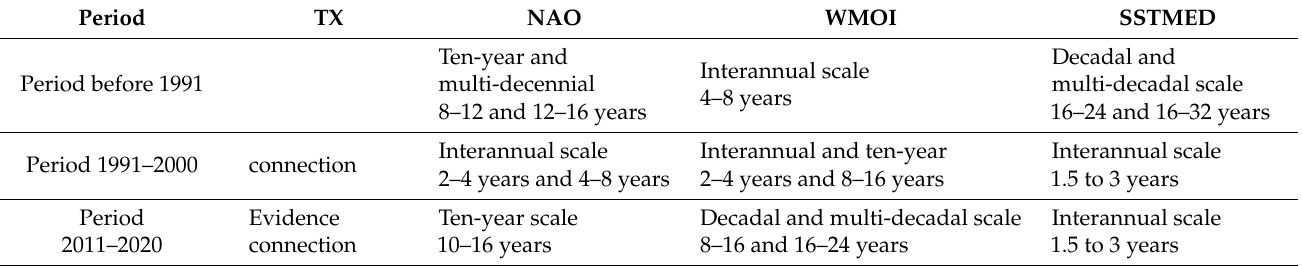
Table 3. Synthesis of the research of correlations between local precipitation, NAO index, WMOI index, the Mediterranean Sea Surface Temperature (SSTMED) and the maximum air temperature